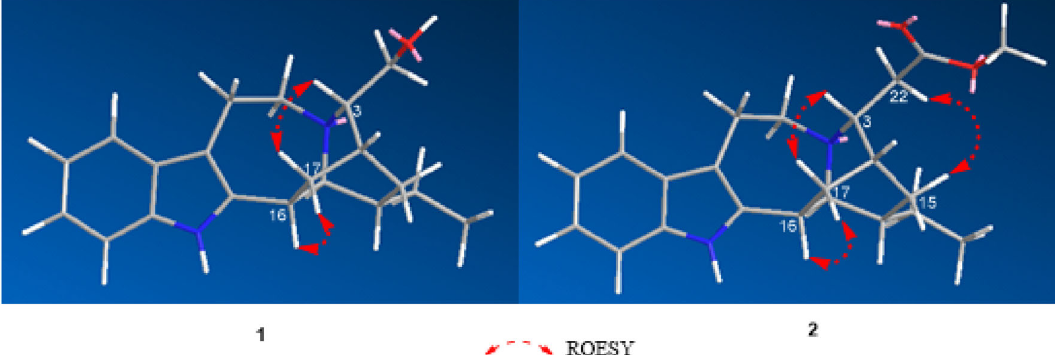
Fig. 3 Key ROESY correlations of compounds 1 and